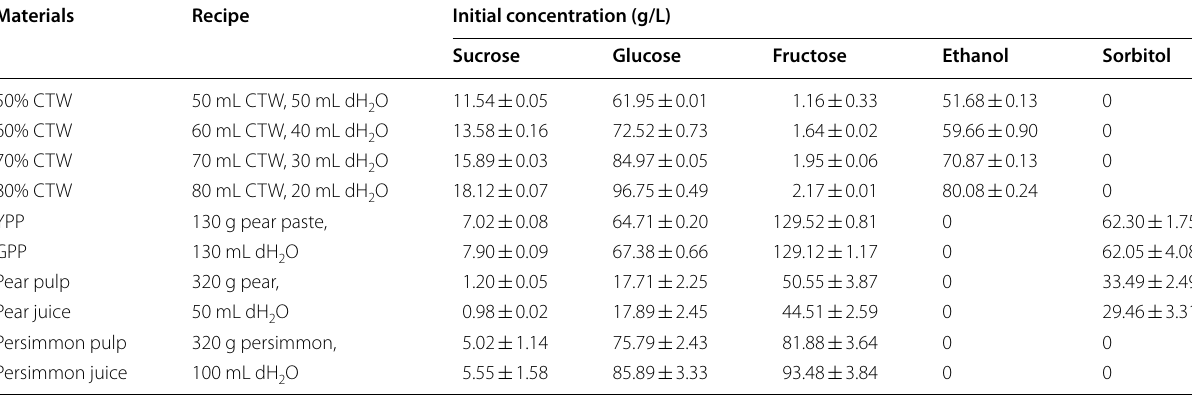
dH 2 O distilled water, CTW Chinese traditional wine, YPP yellow pear paste, GPP green pear paste